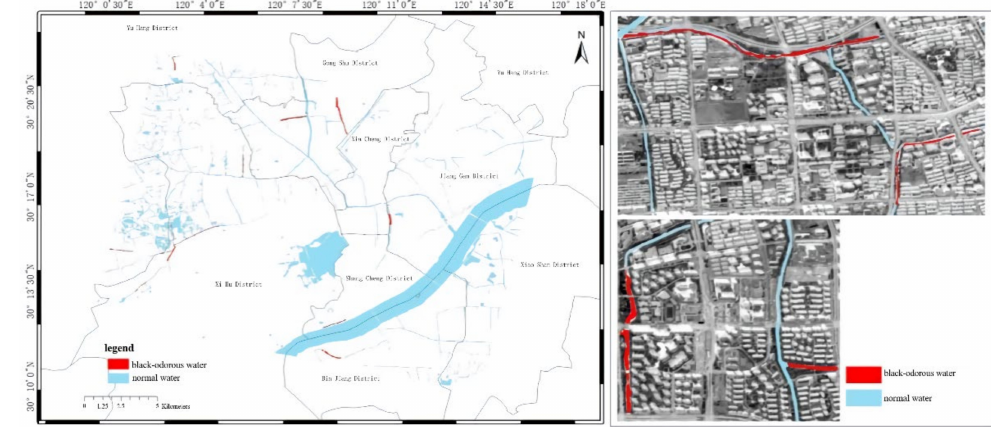
Figure 12. Distribution map of black-odorous water in 2016.